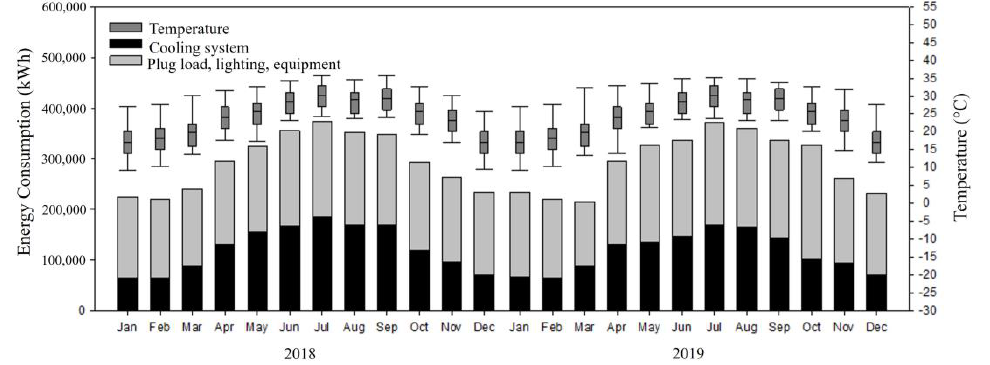
Figure 4. The effect of outside air temperature on energy consumption.